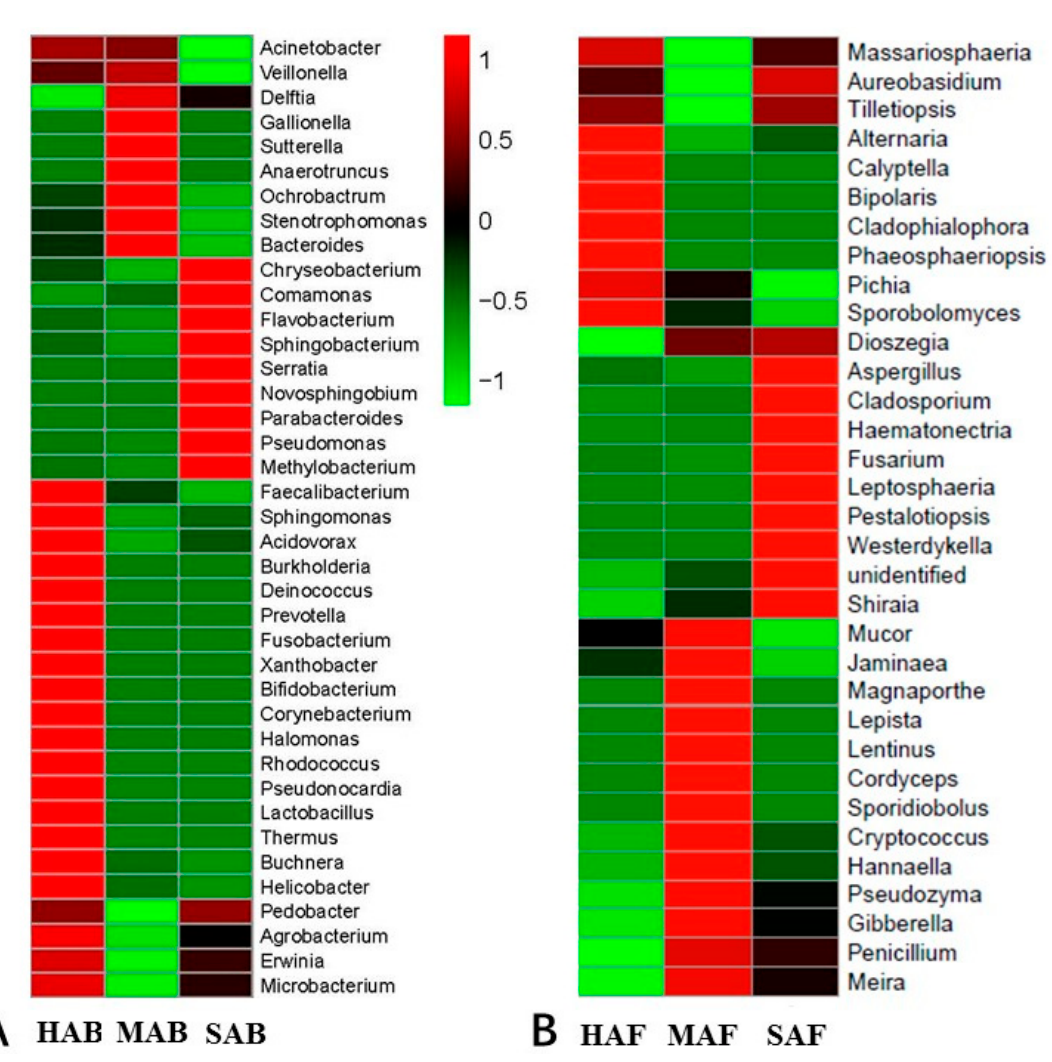
Figure 3. Heat maps showing the bacterial ( A ) and fungal ( B ) genus frequency distribution among the three different conditions of aphids. The different color intensities represent the relative abundance of each genus. HAB and HAF indicate healthy aphids, MAB and MAF mycotized aphids, and SAB and SAF starved aphids.